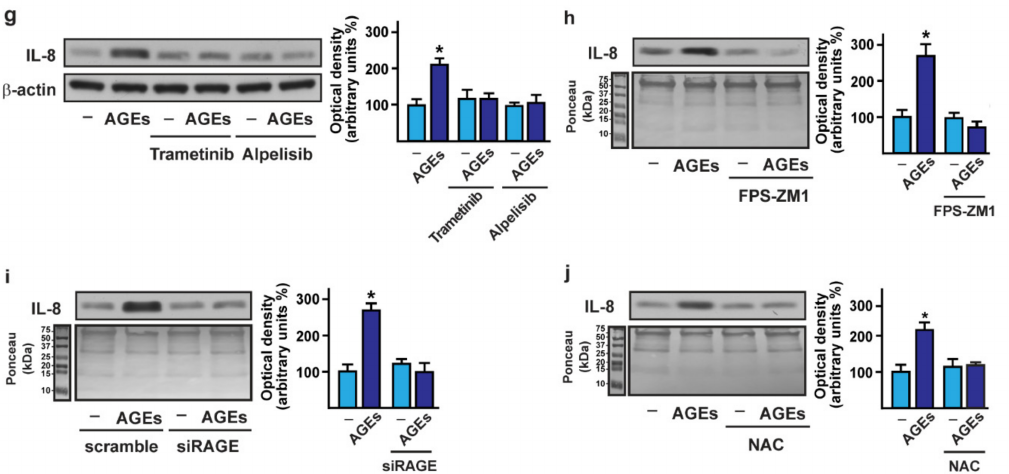
Figure 2. AGEs/RAGE activation upregulates IL-8 expression in CAFs. ( a ) CAFs were exposed for 8 h to 100 µ g/mL AGEs alone and in the presence of 1 µ M RAGE inhibitor FPS-ZM1. Gene expression changes of chemokine and related genes were evaluated by TaqMan™ Human Chemokine Array. Values were normalized to 18 S expression; the colors indicate the log2 fold changes of gene expres- sion upon the indicated conditions in relation to the vehicle-treated CAFs. mRNA ( b , e ) and protein ( c , f ) expression of IL-8 evaluated, respectively, by real-time PCR and immunoblotting in CAFs treated for 8 h with vehicle (–) or 100 µ g/mL AGEs alone and in the presence of 1 µ M RAGE inhibitor FPS- ZM1 or in combination with 300 µ M free radical scavenger NAC. In RNA experiments, values were normalized to the beta-actin (ACTB) expression and shown as fold changes of IL-8 mRNA expression upon AGEs treatment compared to cells exposed to vehicle; ( d ) Immunoblots showing IL-8 protein expression in CAFs transfected with scramble siRNA or siRAGE (10 nM) for 24 h and then exposed for 8 h to vehicle (–) or 100 µ g/mL AGEs; ( g ) IL-8 protein expression evaluated by immunoblot- ting in CAFs treated for 8 h with vehicle (–) or 100 µ g/mL AGEs alone and in combination with 100 nM MEK inhibitor trametinib or 1 µ M PI3K inhibitor alpelisib. β -actin served as a loading control; ( h , j ) Evaluation by immunoblotting of IL-8 protein levels in conditioned medium (CM) collected from CAFs treated for 18 h with vehicle (–) or 100 µ g/mL AGEs alone and in the presence of 1 µ M RAGE inhibitor FPS-ZM1 or in combination with 300 µ M free radical scavenger NAC; ( i ) Immunoblots showing IL-8 protein levels in CM derived from CAFs transfected with scramble siRNA or siRAGE (10 nM) for 24 h and then exposed for 18 h to vehicle (–) or 100 µ g/mL AGEs. Ponceau red staining of the membrane was used as a loading control for the CM. Side panels show densitometric analysis of the blots normalized to the loading controls. Values represent the mean ± SD of three independent experiments. (*) indicates p <